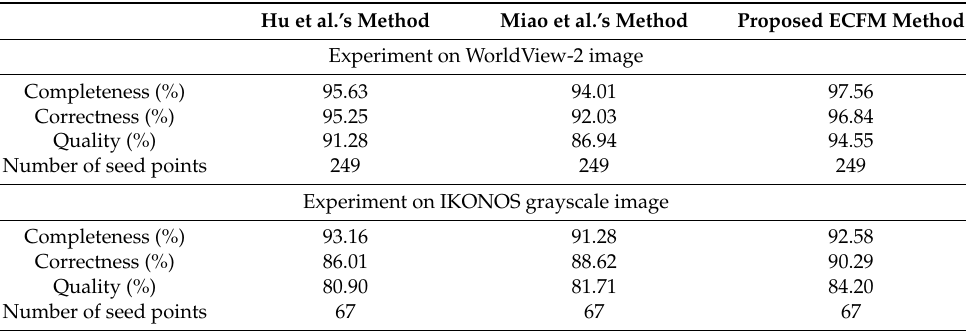
Table 3. Quantitative Evaluation of Different Centerline Extraction